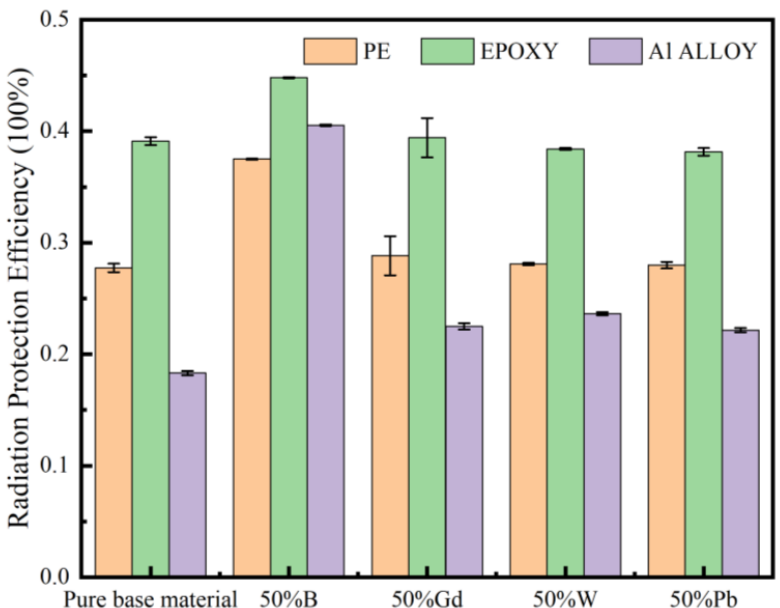
Figure 6. Radiation protection efficiency ( RPE ) of three matrix shielding materials in the neutron radiation field.